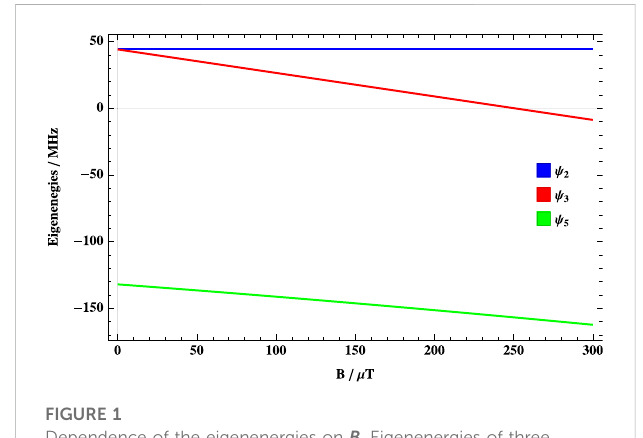
FIGURE 2 Dependenceofthefractionalsingletyieldon B .Dependenceofthe fractional singlet yield for (a) singlet-born ( Φ S ( S ) ) radical pair on the external magnetic fi eld B with one isotropic hyper fi ne coupling of 1,000 μ T for different relaxation rate, r , and reaction rates, k . There is a peak in the hypomagnetic fi eld range for most values of k and r . The peakdiminisheswhen thereaction rate isslowerthan thespin relaxation rate.Onecanalsoseethat thereisadipatintermediate fi eldvalues,then a rise at higher fi elds, but this rise is not as high as the peak for the hypomagnetic fi eld range (see the